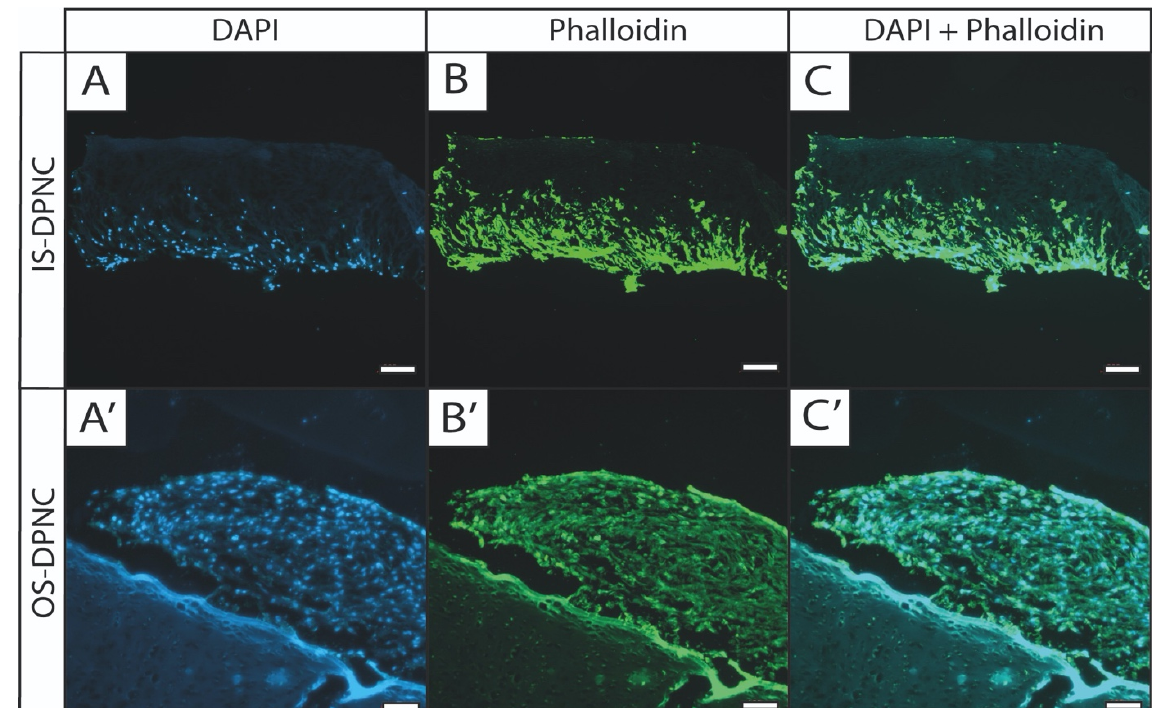
Figure 5. Fluorescence staining shows differences in growth pattern of ASCs between DPNC zones. DPNC scaffolds seeded with ASCs were cultured for 28 days, and were subjected to fluorescence staining with DAPI (blue, visualizes cell nucleus; A , A ’) and phalloidin (green, visualizes the actin cytoskeleton; B , B ’). Right column ( C , C ’) shows overlaid images. ASCs seeded on IS clearly migrate into the scaffold ( A – C , bar = 200 μ m), whereas ASCs on OS form multilayer cell stacks on surface of scaffolds ( A ’– C ’, bar = 100 μ m) (n = 3).